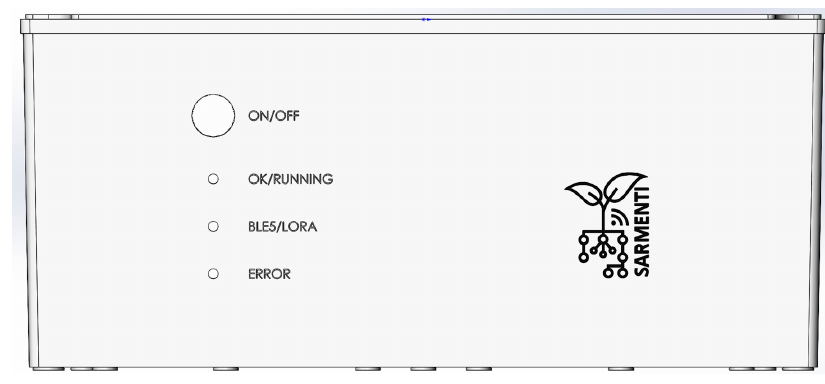
Figure 9. Smart Data Logger enclosure front view. Figure 9 . Smart Data Logger enclosure front view .